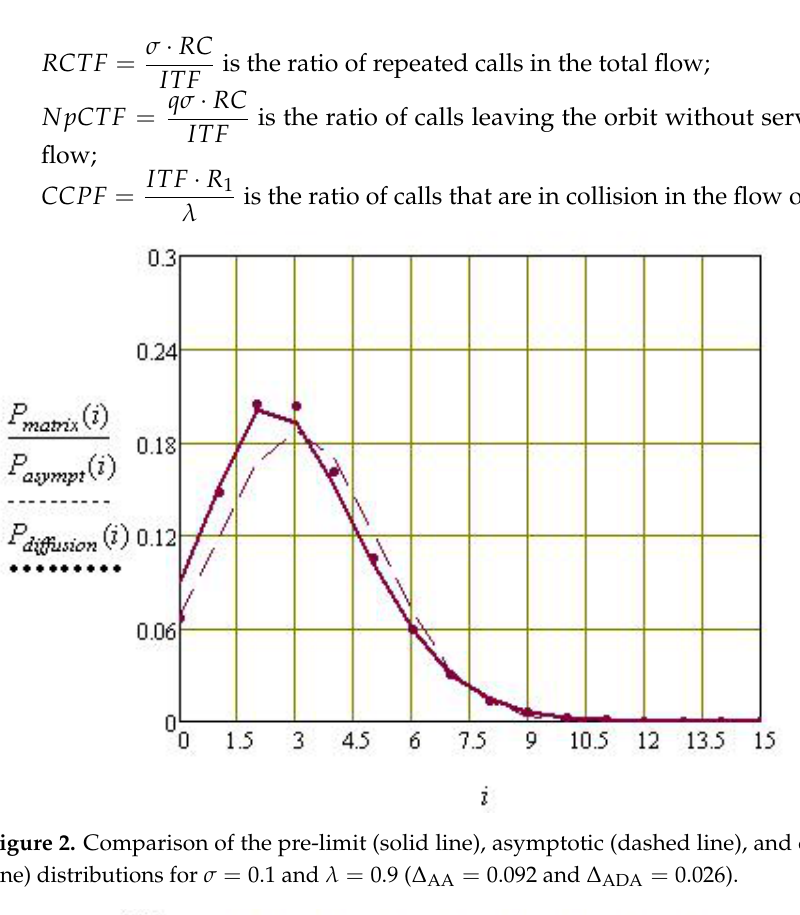
Figure 2. Comparison of the pre-limit (solid line), asymptotic (dashed line), and diffusion (dotted line) distributions for σ = 0.1 and λ = 0.9 ( ∆ AA = 0.092 and ∆ ADA = 0.026).